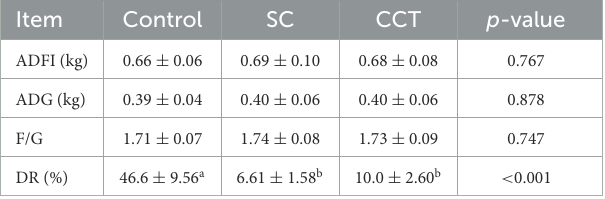
TABLE 2 Effects of CCT on growth performance and DR of weaned piglets.